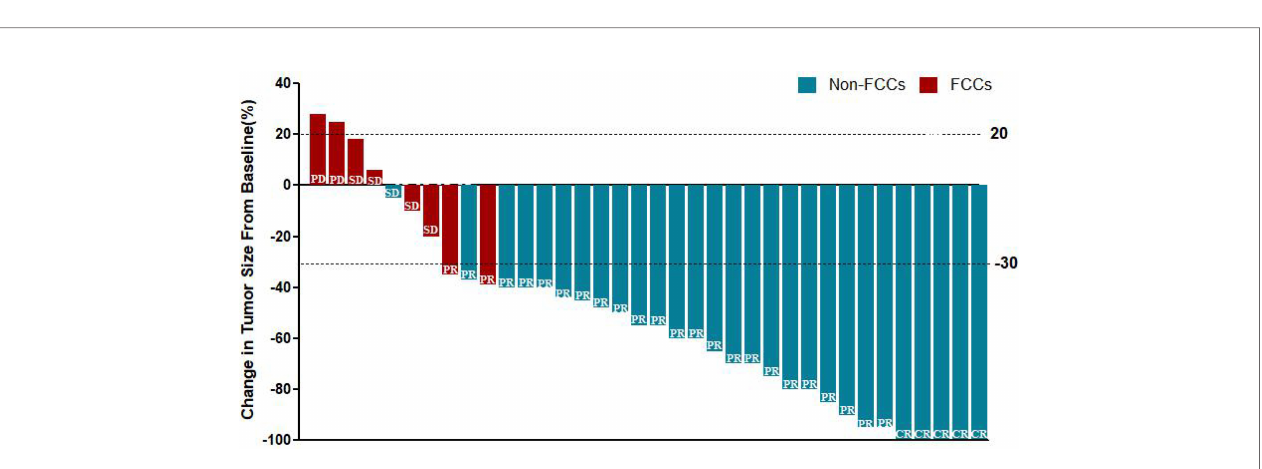
FIGURE 5 | A waterfall plot of ranked best tumor shrinkage.